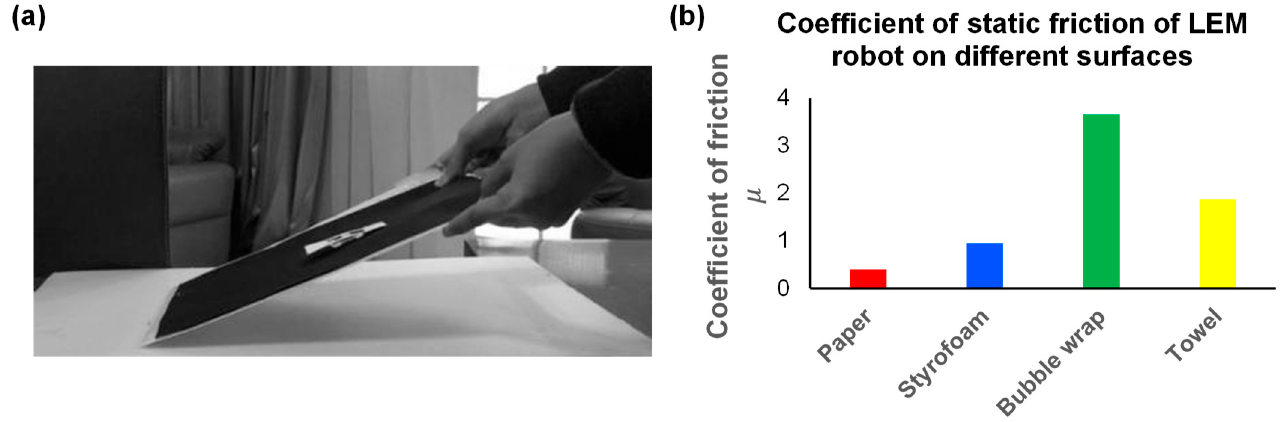
Figure 15. Frictional properties of SLEM mechanism: ( a ) Coefficient of static friction µ between SLEM and different surfaces. ( b ) Sliding test between SLEM mechanism and the frictional surface. Angle θ is recorded to calculate μ . Angle θ is the angle at which the SLEM mechanism starts sliding on the surface on which it is placed. LEM is placed in a popped-up configuration with legs perpendicular to the surface at the start of the test.